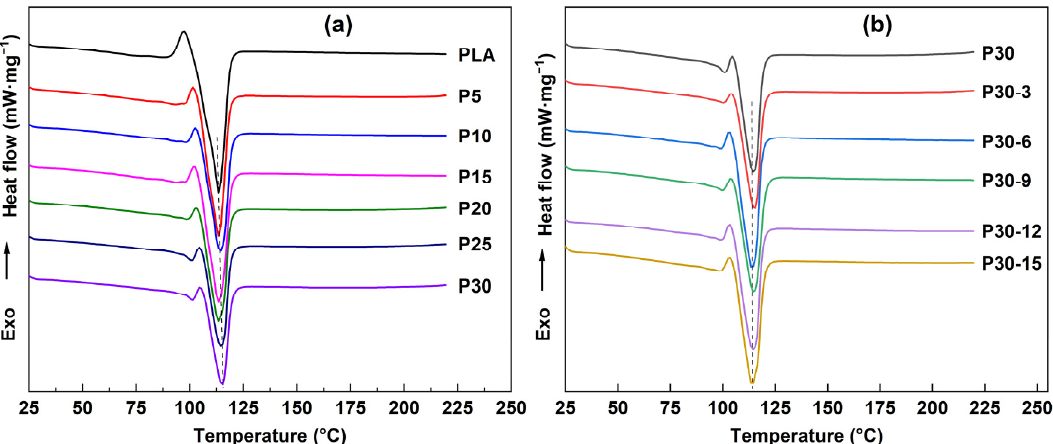
Figure 3. ( a ) DSC curves of PLA and WCPF/PLA composite with different contents of WCPF. ( b ) DSC curves of the WCPF/PLA composite with 30 wt% WCPF treated by different contents of KH-550 coupling agent.